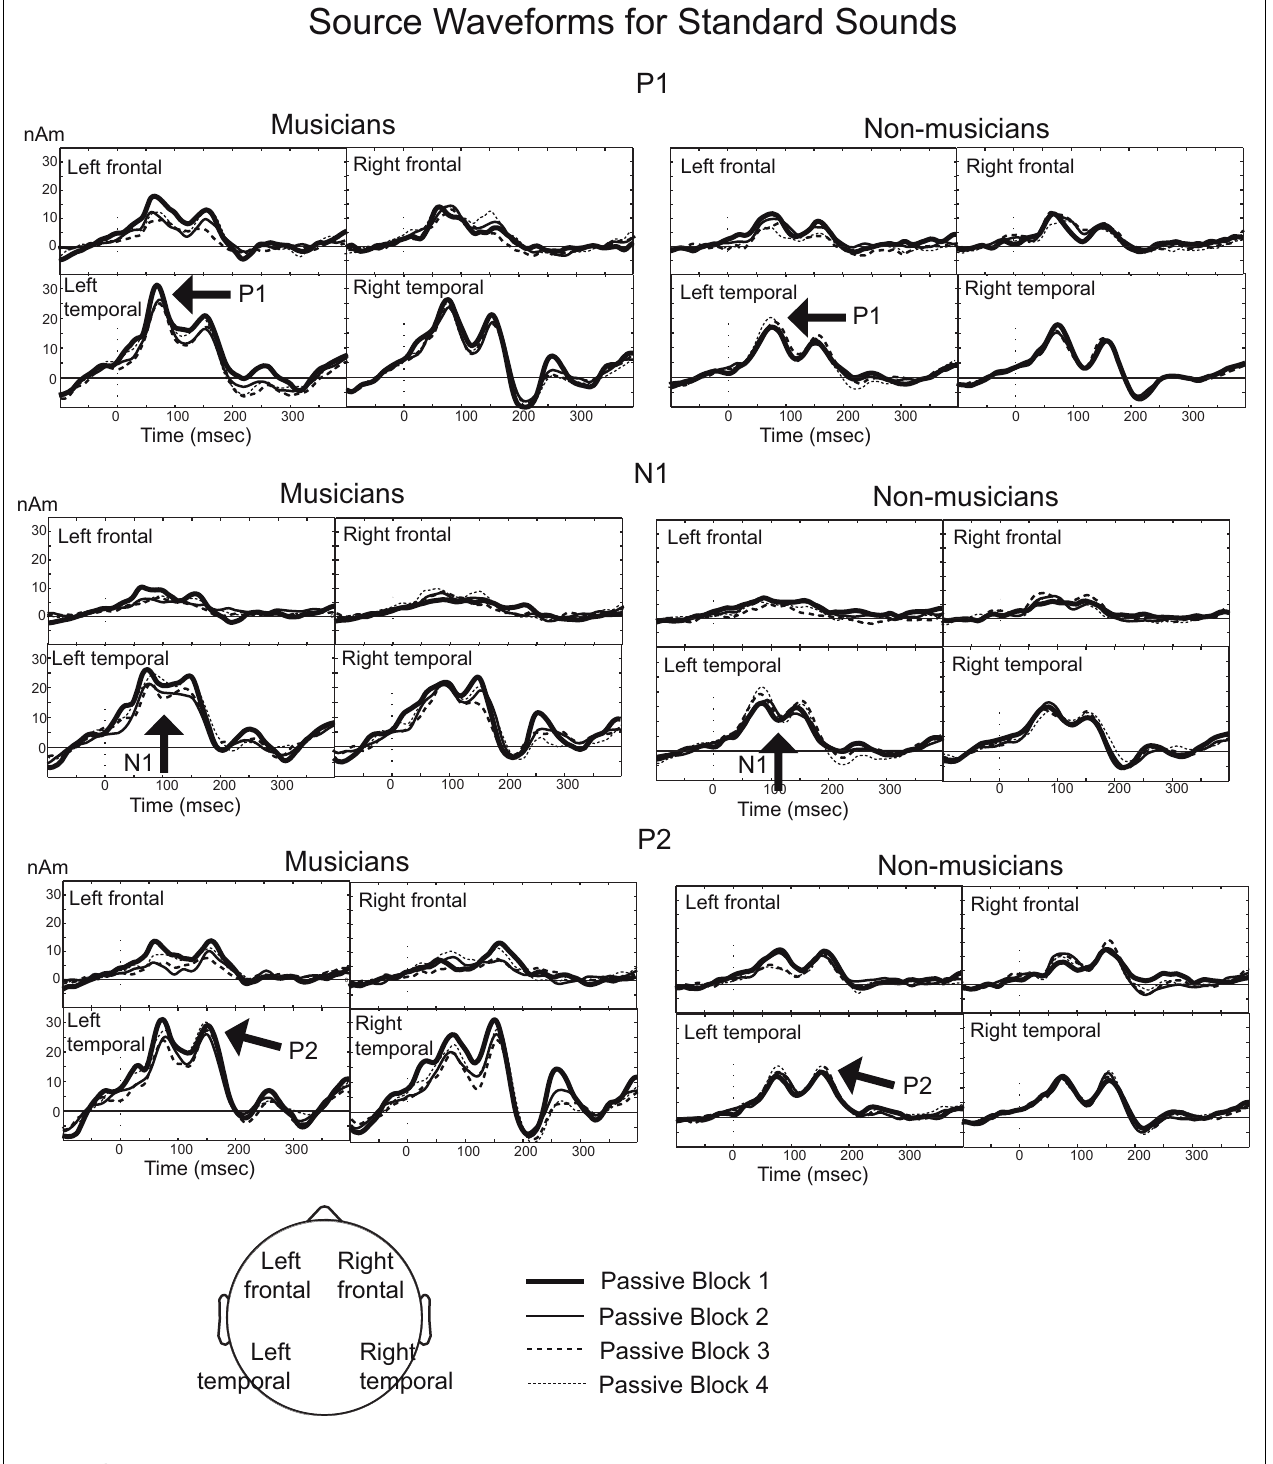
FIGURE 3 | Source waveforms for P1, N1, and P2 for standard